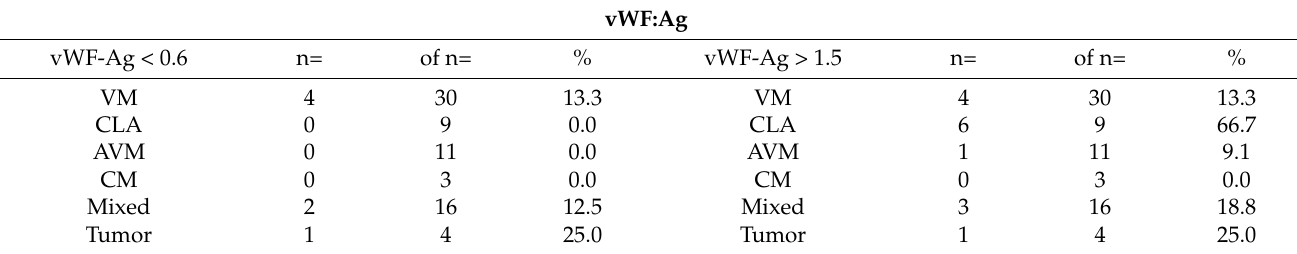
Table 3. Alterations in vWF:Ag specified by disease. vWF:CB was changed in the same patients.